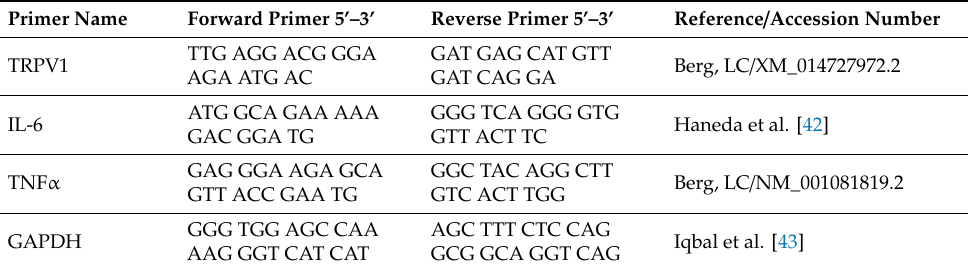
Table 5. Species-specific